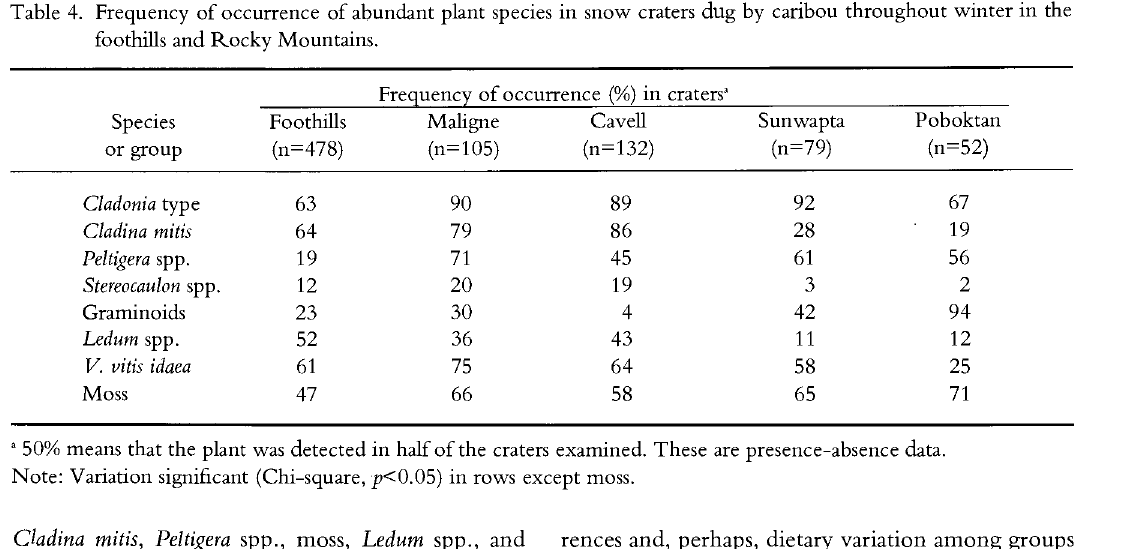
Table 6. Percent composition (dry weight) of plant spe cies in two mixtures simulating the apparent diet of caribou in the mountains in early and late winter and microhistological